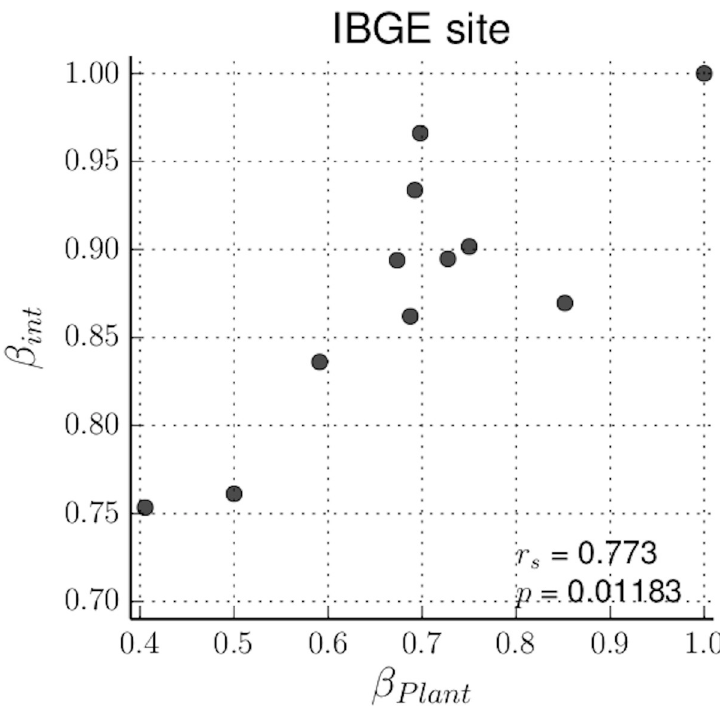
Fig 6. Network robustness to the simulated extinctions of pollinator and plant species in the studied community. Curves reflect extinction simulations results with removal following a decreasing rank of species importance (i.e., from largest to smallest values) in degree for robustness to species loss, and weighted degree for robustness to loss of flow. Dots indicate species loss robustness results as the proportion of species remaining in the community after removal; lines indicate flow robustness as the proportion of visitations being made or received after removal; red indicates dry season results, blue refers to interactions recorded during the rainy season, and black refers to the results considering the entire, aseasonal community. Significance of differences in robustness are indicates by asterisks for the removals by decreasing aseasonality (degree) in terms of overlap in the 95% confidence intervals (CI) around the AUC curves, as well as the proportion of nodes or visitation services remaining after removal (in parentheses, ± 95% CI). For significance of differences in robustness of low to high degree and random removal of species, see supplementary